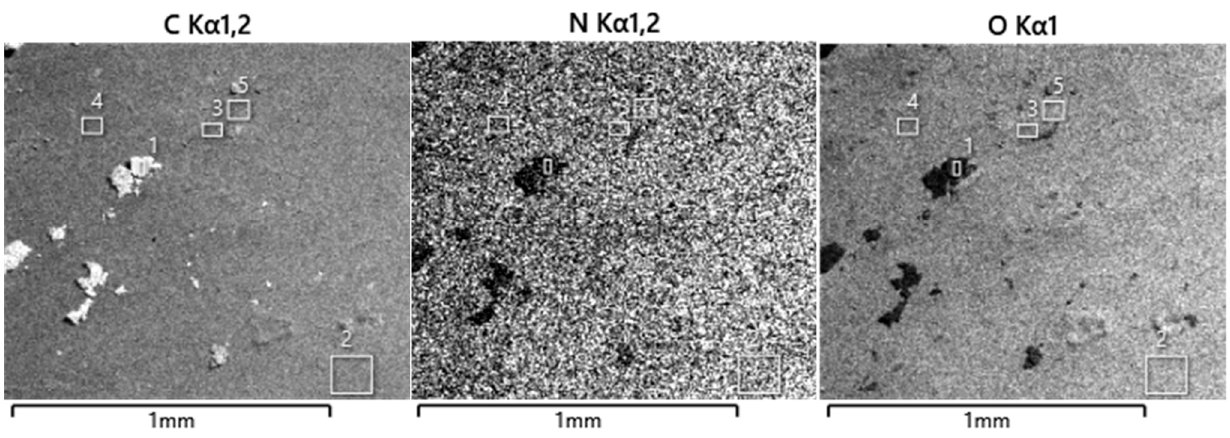
Figure 4. EDS image of CS-MB hydrogel. Conditions: Samples immobilized to carbon tape and coated with 5 nm of iridium for conductivity and then imaged at 5 kV.